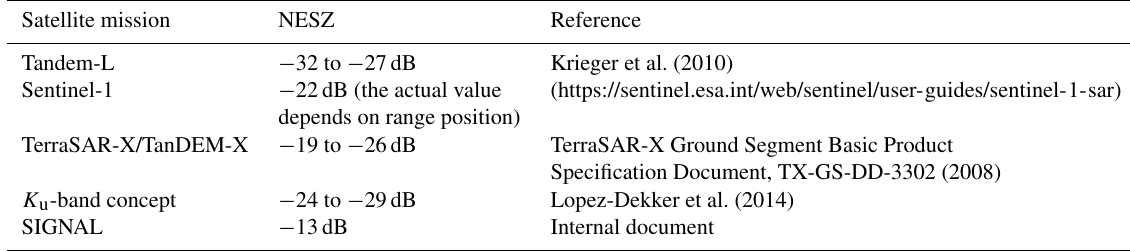
Table 2. Noise-equivalent sigma zero (NESZ) for different satellite missions. Satellite mission NESZ Reference